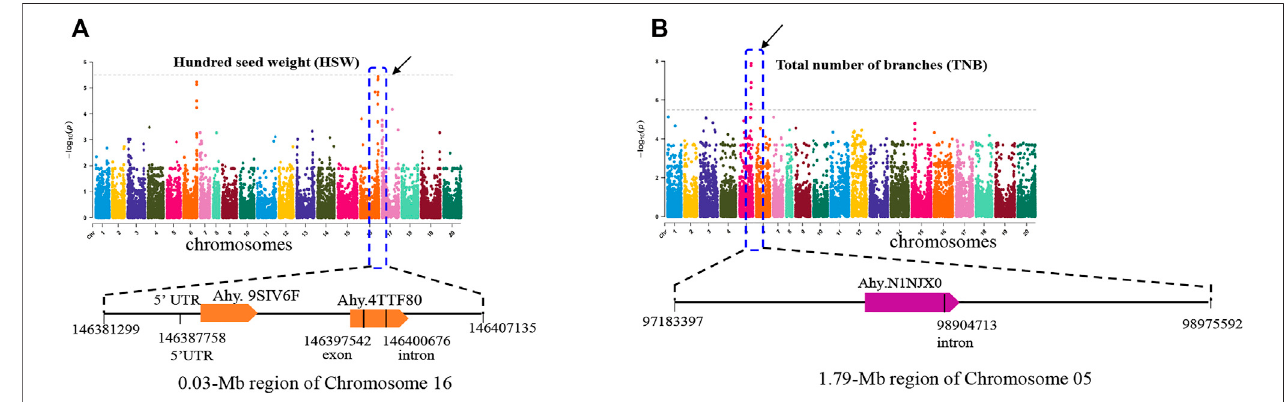
FIGURE 4 | GWAS signals for hundred seed weight (A) and total number of branches (B) of peanut. The signi fi cance level is log10 (0.05/13125) = 5.4 (the gray horizontal line). The characteristic analysis of functional genes in the screening intervals is shown below each Manhattan